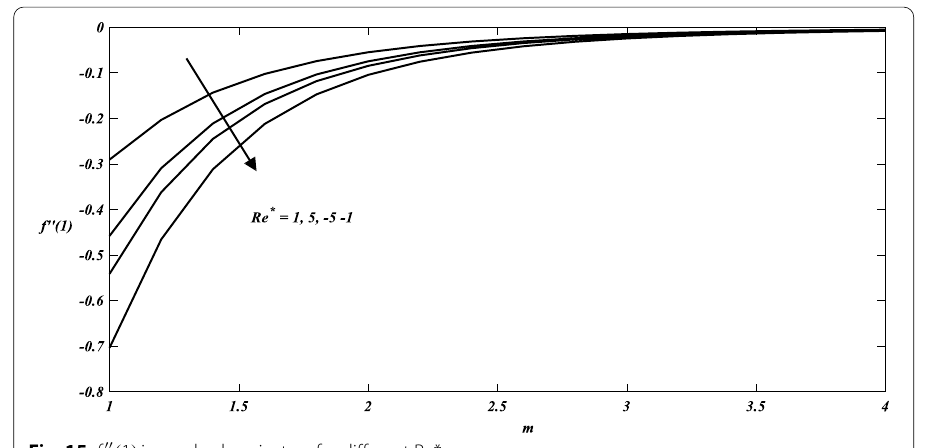
Fig. 15 f ′′ ( 1 ) is graphed against m for different Re*